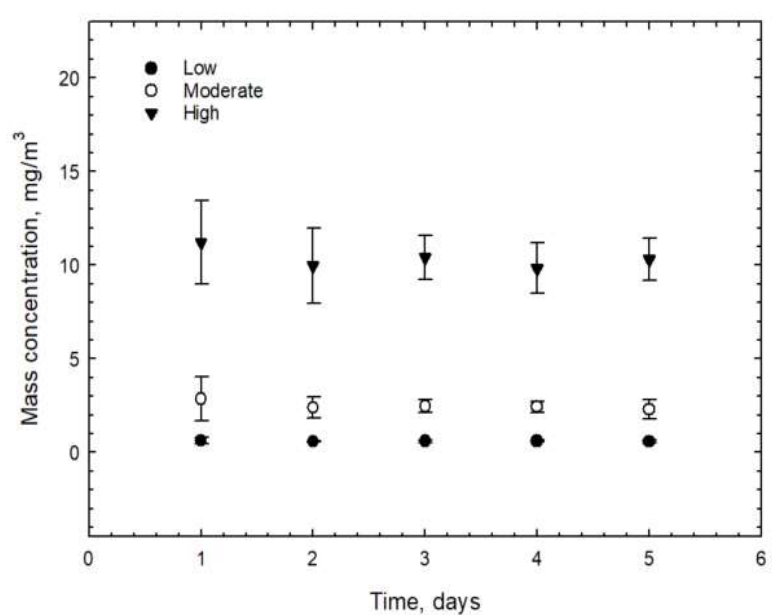
Figure 4. Maintenance of CNF concentrations in inhalation chamber during 5 days exposure.